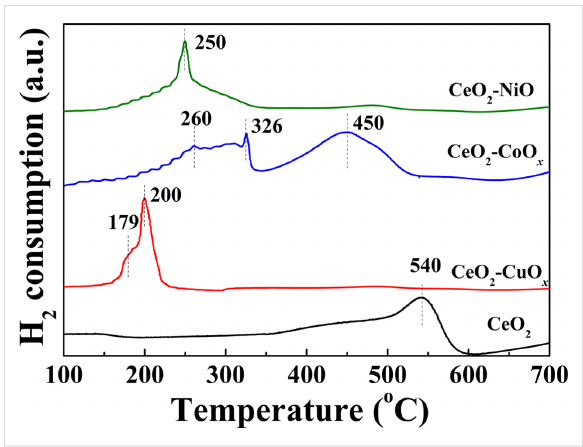
Figure 8: H 2 -TPR profiles of as-prepared CeO 2 , CeO 2 –CuO x , CeO 2 –CoO x and CeO 2 –NiO yolk–shell nanospheres.